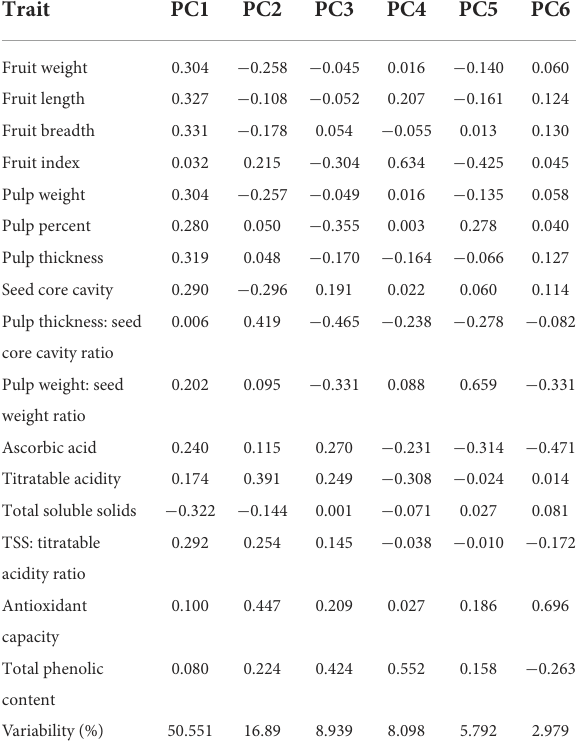
TABLE 5 First 6 components from the PCA analysis of 16 quantitative traits in 28 guava